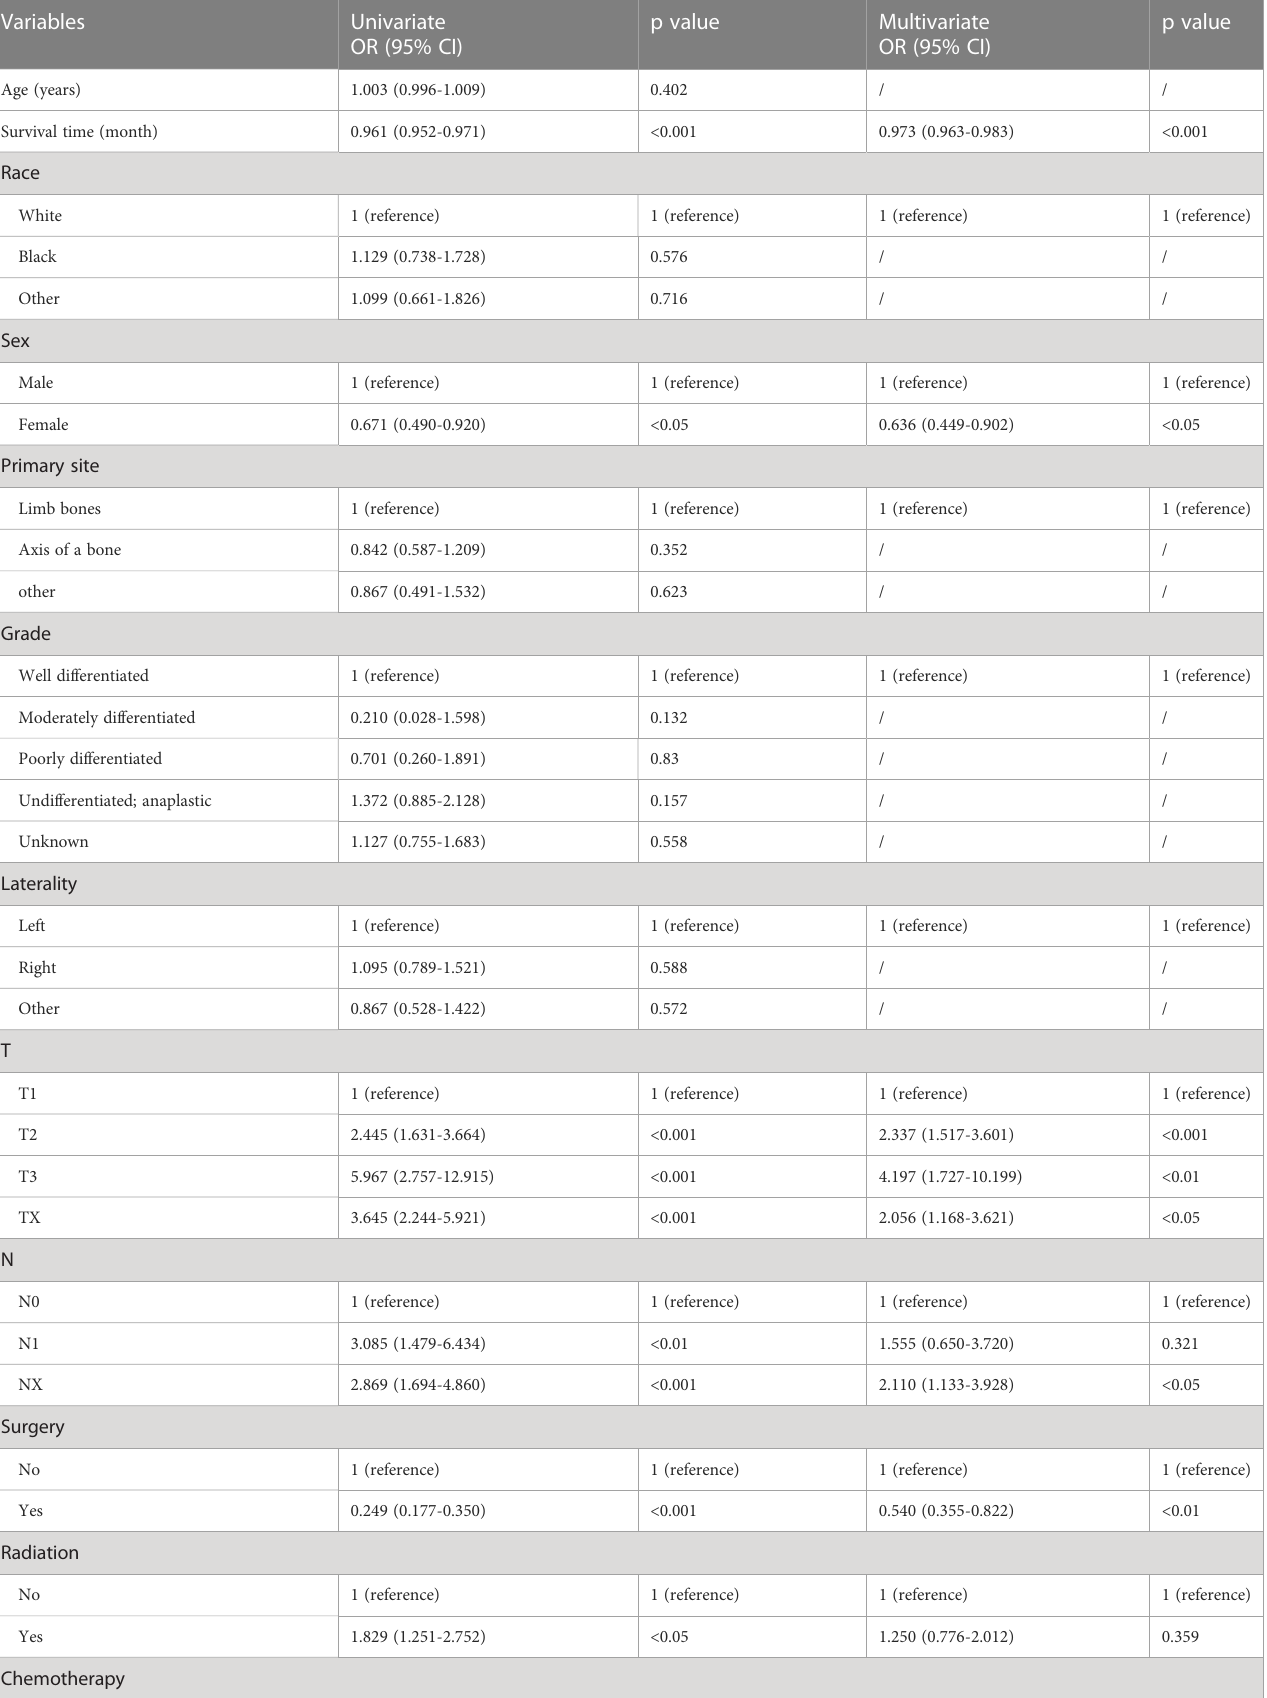
TABLE 3 Univariate and multivariate logistic regression analysis of risk factors for lung metastasis in patients with